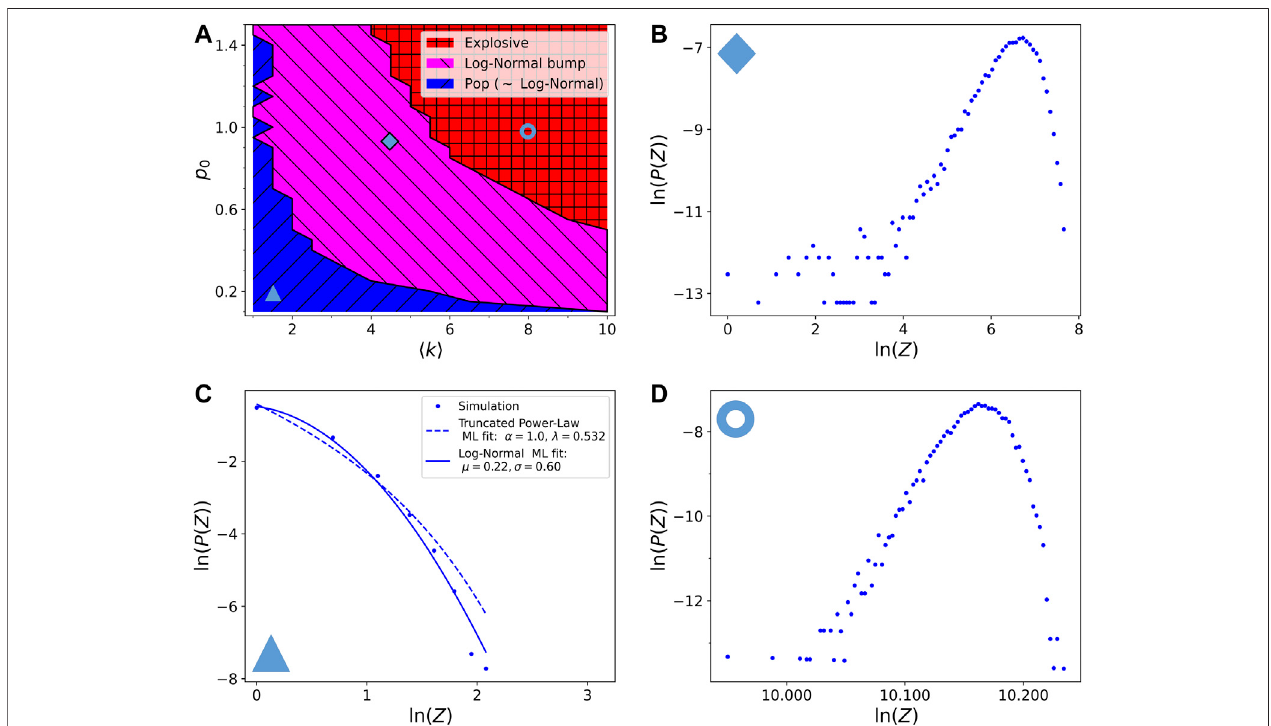
FIGURE5|(A) Phasediagramoftheresultingavalanchesizedistributionswithrespecttothemodelparameters 〈 k 〉 and p 0 ,theconstantpre-factorofthebreaking probability (see Eq. 8 ). The time constant is here τ (cid:1) 1 and the rheological exponent is again fi xed at (cid:1) 0.3. Symbols indicate the points taken to show some distribution examples in the remaining panels. The pop (blue) and explosive (red) regimes are the same as in Figure 3 , while the log-normal bump regime is composed of approximately log-normally distributed avalanche sizes (in magenta). Note that here this regime is much wider than in Figure 4 because of the choice of τ . (B) Example distribution of the log-normal bump regime with coordinates at the diamond point ( 4 . 5 , 0 . 95 ) ; (C) Example distribution of the pop regime, with coordinated at the triangle point ( 1 . 5 , 0 . 2 ) . Dots show the simulation distribution and the full (resp. dashed) line shows the maximum of likelihood fi t with a log-normal (resp. truncated power-law) distribution; (D) Example distribution of the explosive regime, with coordinates at the doughnut point ( 8 , 1 )